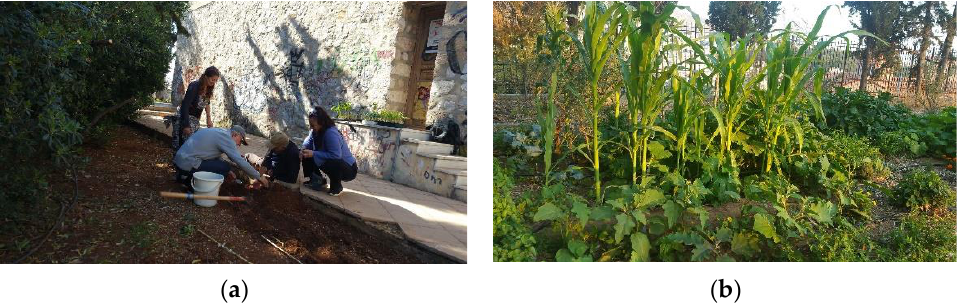
Figure 1. Preparing the garden beds and yielding the first crop. (Photos credits: Nicholas Anasta- sopoulos ( a ) and Monica Vaxevani ( b )).